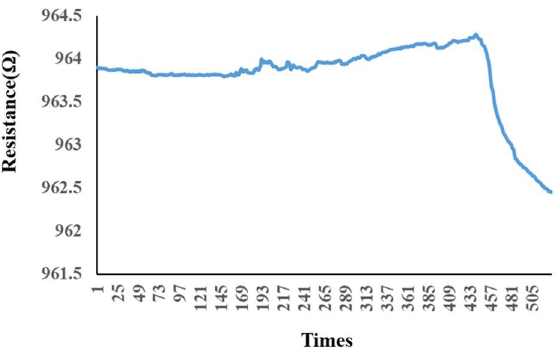
Figure 8. Variation of the micro hydrogen sensor after hydrogen was admitted and after oxygen was admitted.